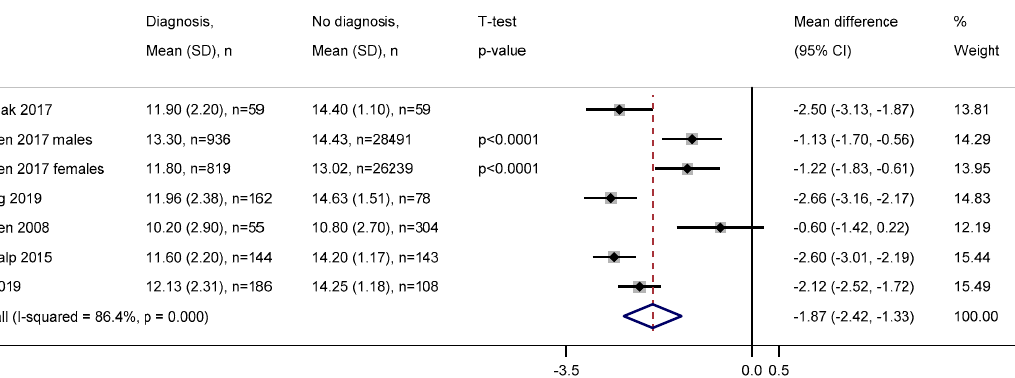
Figure 3. Forest plot of mean difference in haemoglobin between those with and without a diagnosis of colorectal cancer zero to six months later. Abbreviations: SD = standard deviation, CI = confidence interval. Haemoglobin measurements are in g/dL.